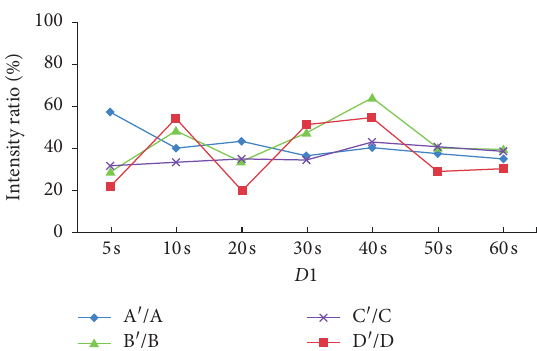
Figure 4: The intensity ratio of different carbon atoms plotted against different D 1 time points.